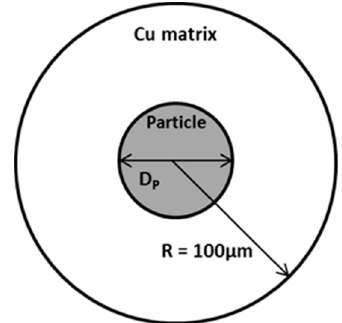
Figure 2. Schematic representation of the system used for DICTRA calculations. The D P obtains values 1 μ m, 5 μ m, 7 μ m, 10 μ m.